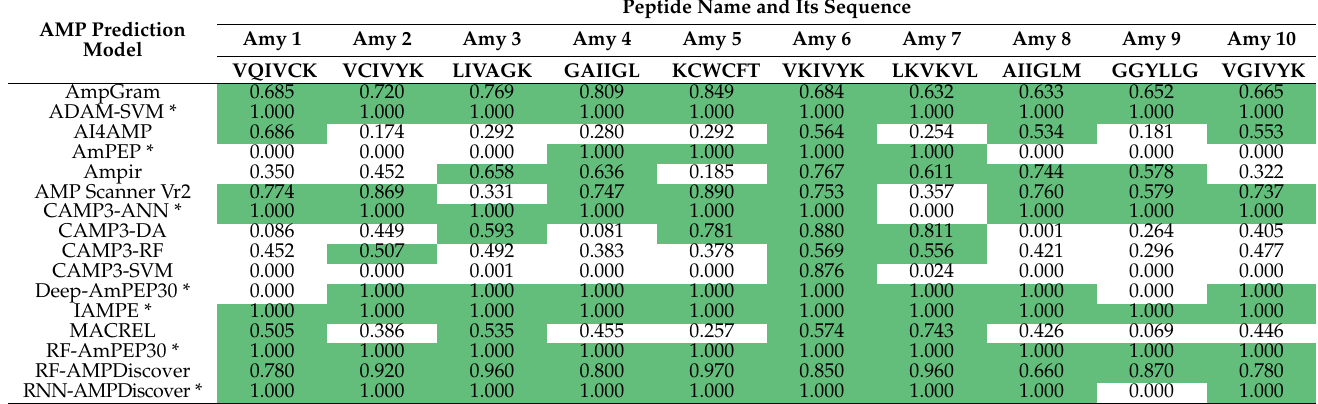
Table 1. Classification of 10 amyloids, indicated by AmpGram with the highest AMP probability, using 15 alternative AMP prediction models. Values greater than 0.5 were colored in green and indicate potential AMP properties. Models marked with asterisks (*) produced zero-one outputs, without giving the probability. Citations for the models are provided in the Materials and Methods section. Amy =